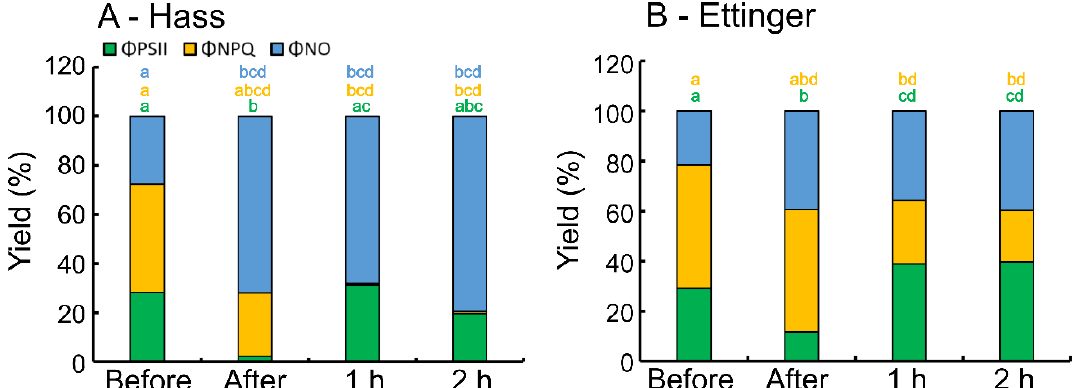
Figure 1. Distribution of absorbed light energy in avocado cultivars Hass ( A ) and Ettinger ( B ) ( P. americana Mill) before and after frost stress. Each bar is divided into: green—yield of photochemistry of PSII ( Φ PSII); yellow—yield of regulated non-photochemical quenching of PSII ( Φ NPQ); and blue—yield of the non-regulated energy dissipation of PSII ( Φ NO), respectively. N = 6, letter annotation refers to statistically significant differences between time instances at p < 0.05.